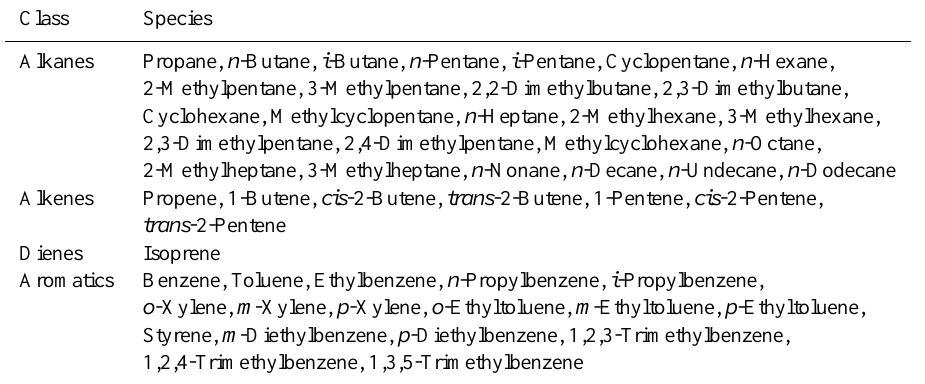
Fig. 1. Wind speed and direction at the Backgarden field site from 5 to 30 July. The ordinate scale refers to the north-south component of wind speed. The orientation of the black arrows denotes wind direction and the arrow length represents total wind speed. The horizontal blue double arrows show the time periods of typhoon Bilis and Kaemi. Table 3. Volatile organic compounds measured by online